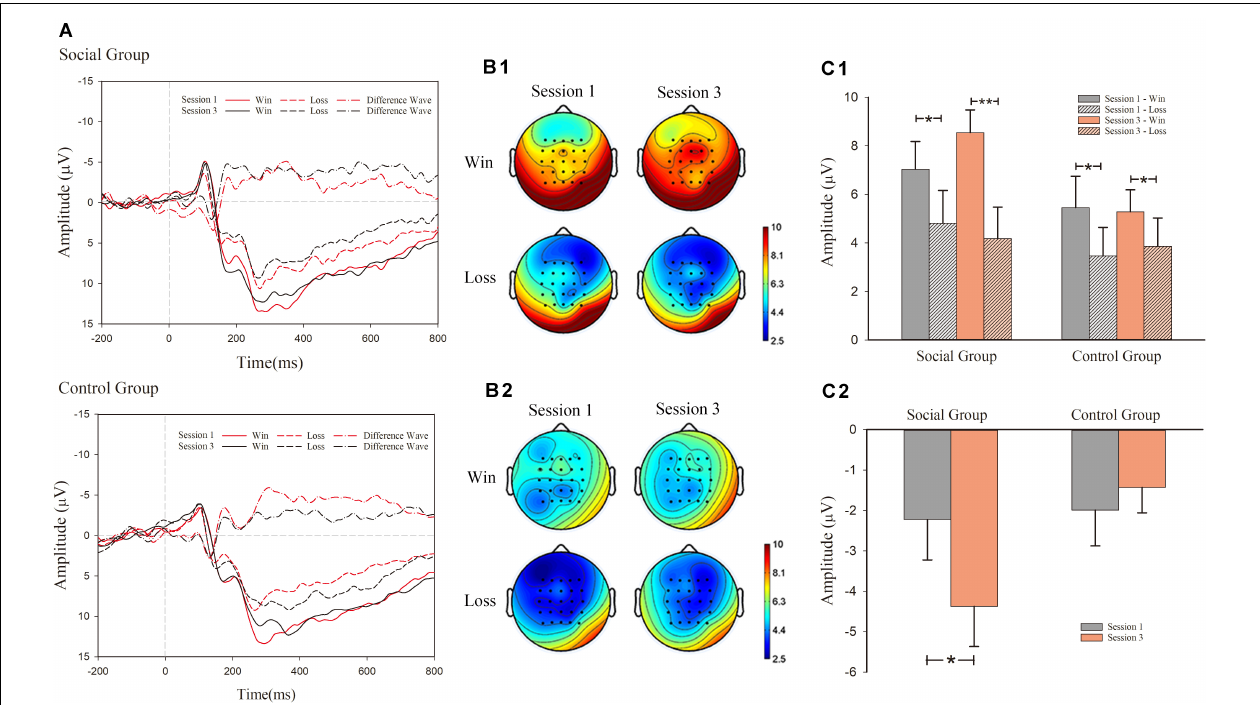
FIGURE 3 | Event-related potential (ERP) results for feedback-related negativity (FRN). (A) grand-average ERP waveforms of FRN from the average voltage of all the electrodes were plotted as a function of session (first and third) and outcome (success and failure) in the social and control groups. In addition to that, the differentiated FRN was also plotted. (B1) FRN topography map of social group; (B2) FRN topography map of control group; (C1) mean voltage of FRN in social and control groups; (C2) mean voltage of d-FRN in social and control